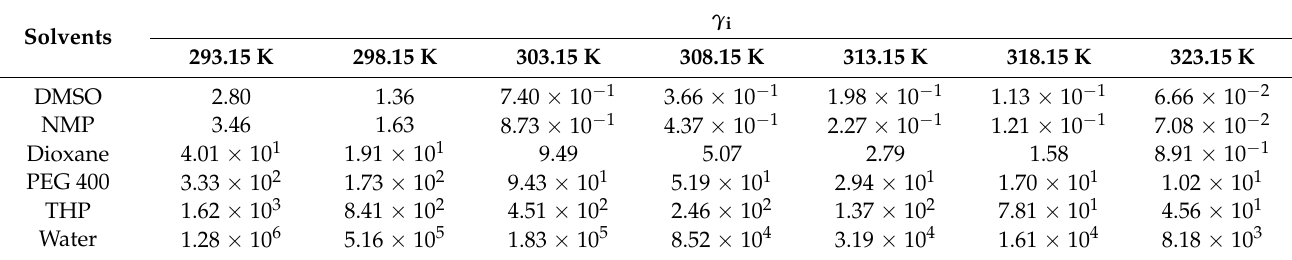
Table 8. Activity coefficients ( γ i ) of GLN in various solvents at T = (293.15~323.15)